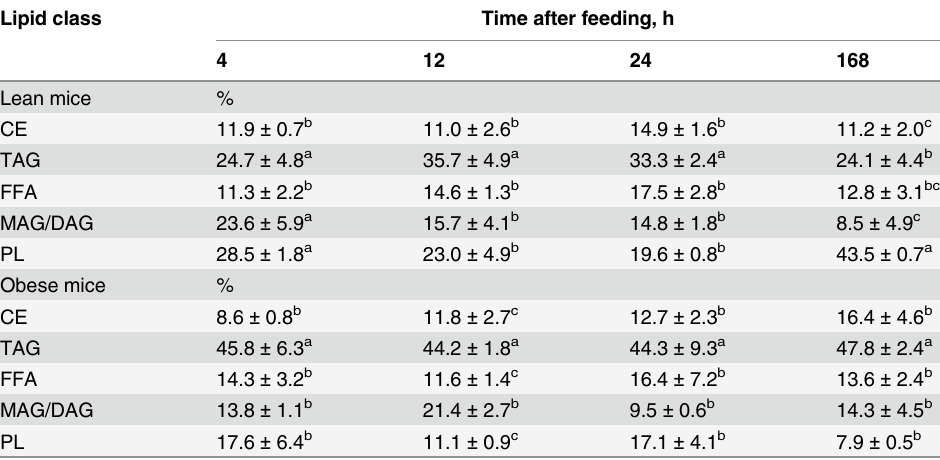
1 The data shows the percentage of each lipid class in total lipid of SAT from lean or obese mice. Data are presented as the mean ± SEM (n = 3). The means in the columns with superscripts without a common letter differ ( P < 0.05).